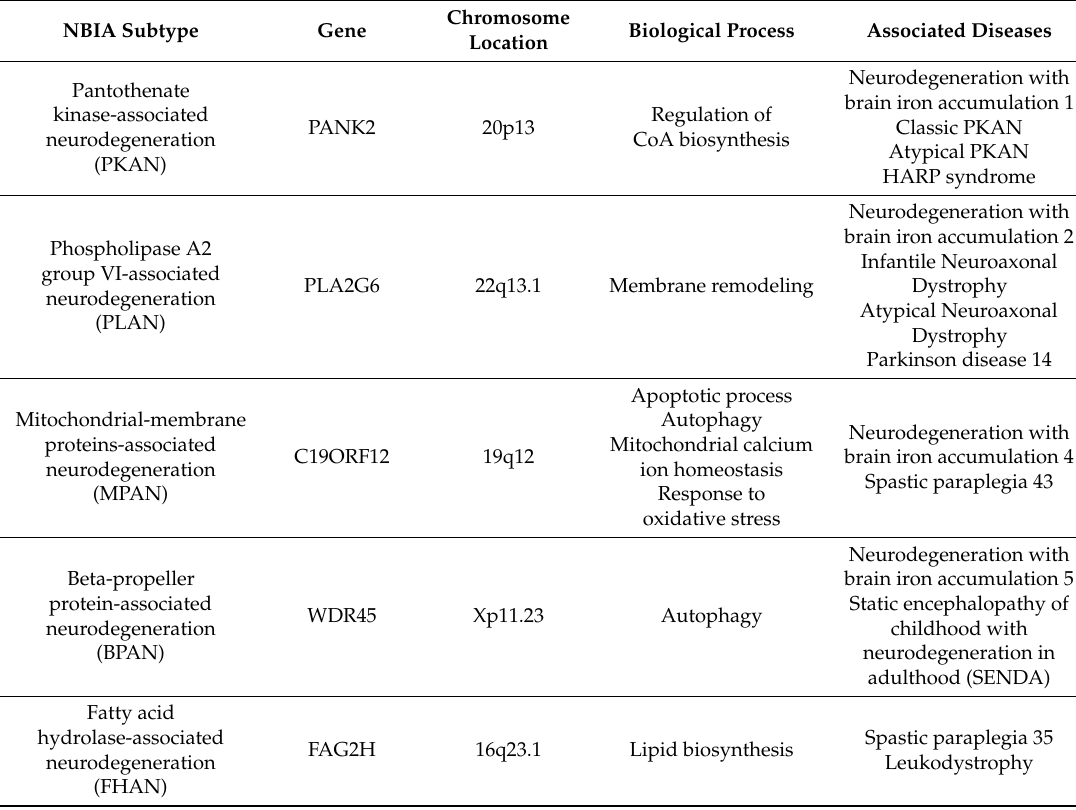
Table 1. Neurodegeneration with brain iron accumulation (NBIA) subtypes under study in the Braincure